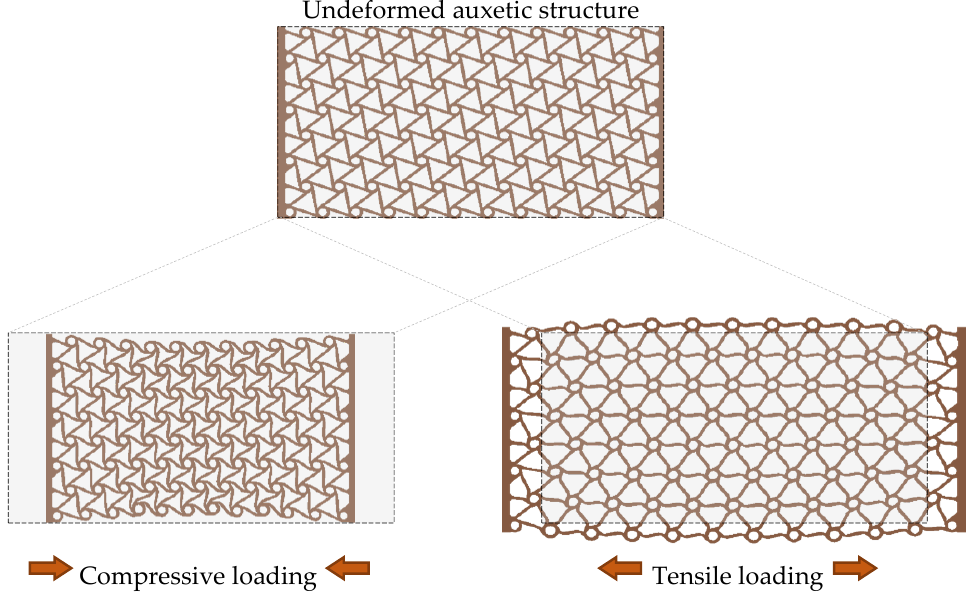
Figure 1. The behaviour of auxetic cellular structures under compressive and tensile loading.